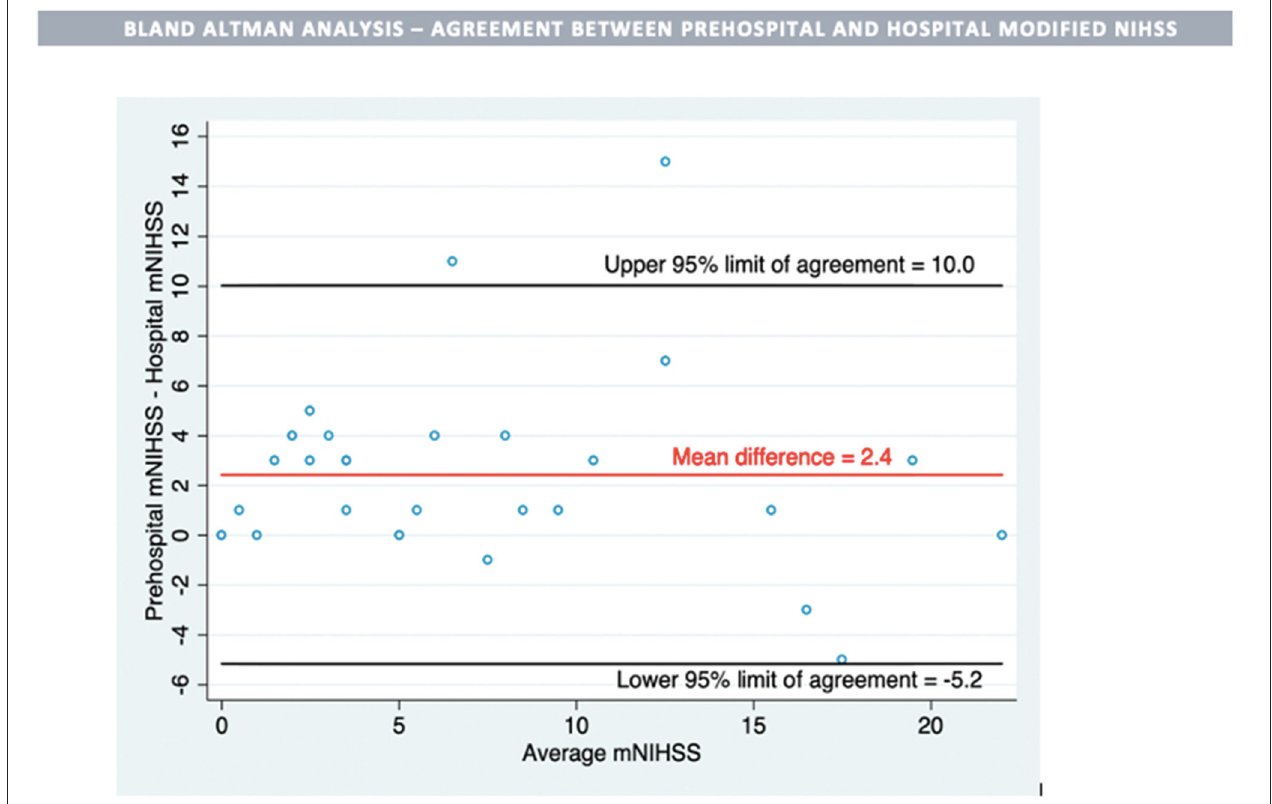
FIGURE 1 | One patient was excluded from comparison due to change in clinical condition during prehospital transport.